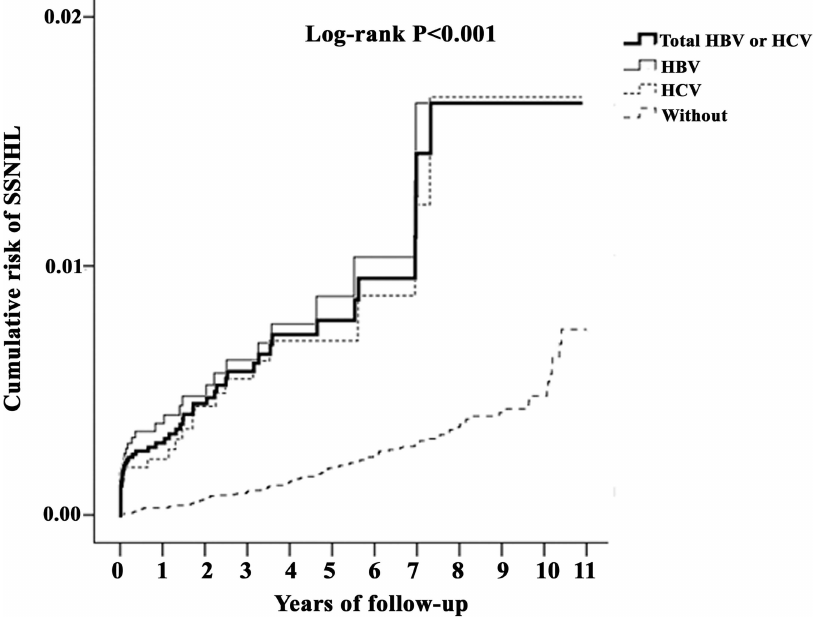
Fig 2. Kaplan–Meier curves for the cumulative risk of SSNHL among patients aged (cid:21) 20 years with HBV/HCV infection (stratified by HBV or HCV alone, using the log-rank test).